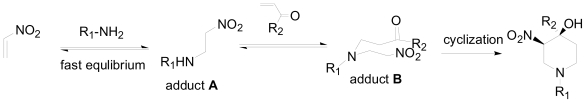
Proposed one-pot cascade piperidine synthesis.